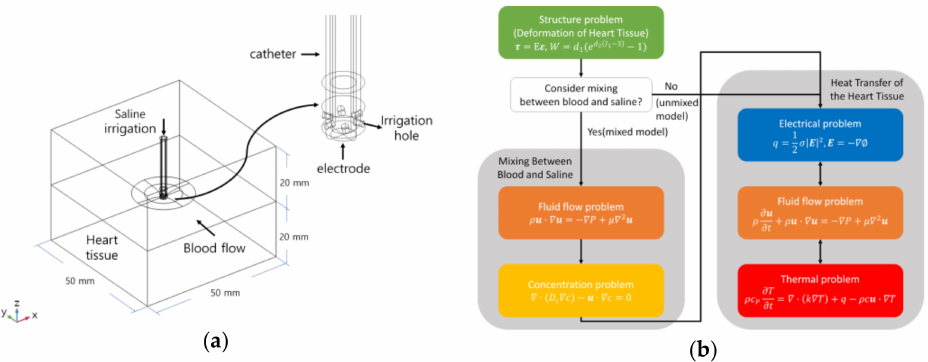
Figure 1. Definition of the model in the heat transfer of the heart tissue ( a ) and schematic diagram of the numerical model ( b